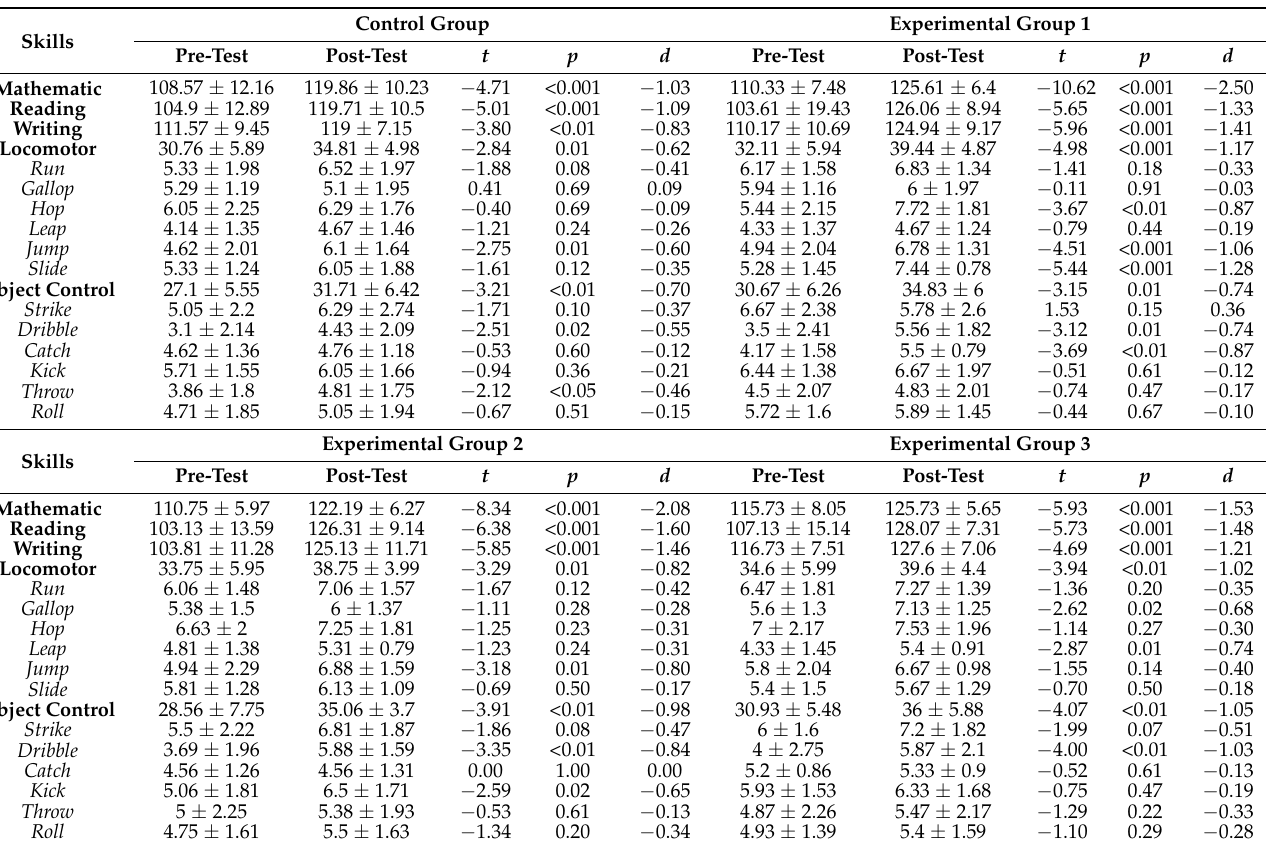
Table 1. Mean and standard deviation of the control and experimental groups in the pre- and